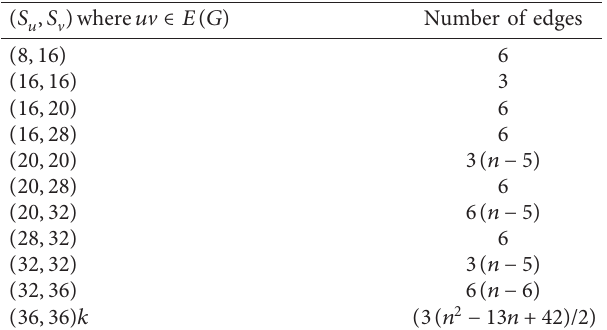
Table 4: Edge partition of T n centred on the number of the vertices of the degree lying at distance 1 from the end vertices of each